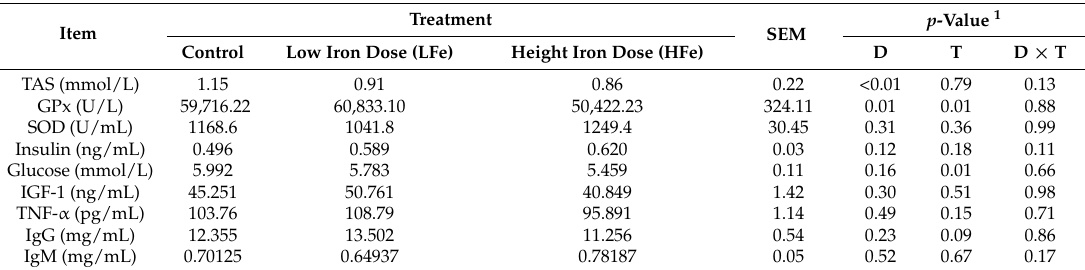
Table 3. TAS, GPx, SOD and concentration of selected biochemical and immunological parameters in calf